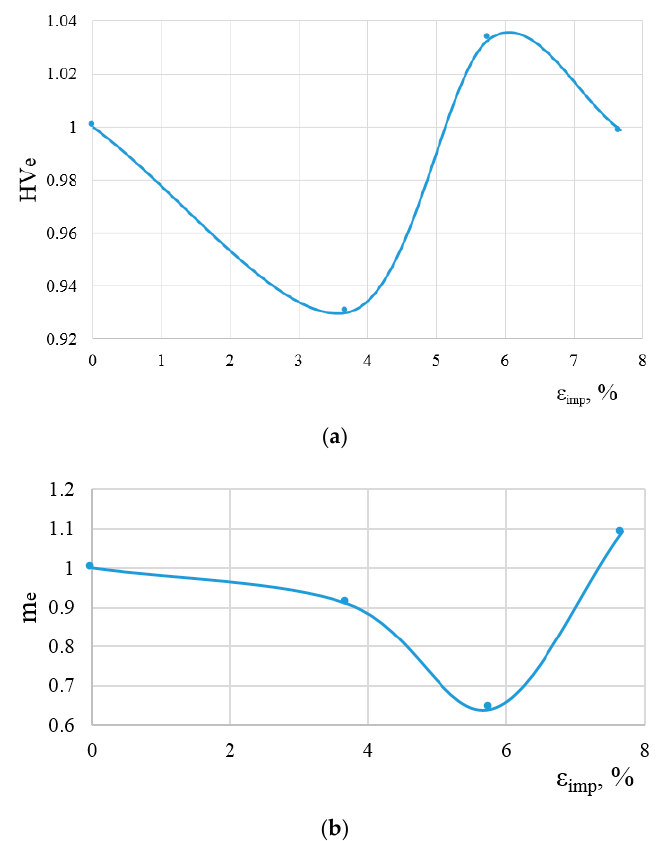
Figure 7. The effect of the intensity of the impulse energy introduction into alloy D16ChATW depending on parameter ε imp , which causes changes in the relative value of parameter HV e ( a ) and relative value of parameter m e ( b ) (maximum cycle stress σ max = 400 MPa).